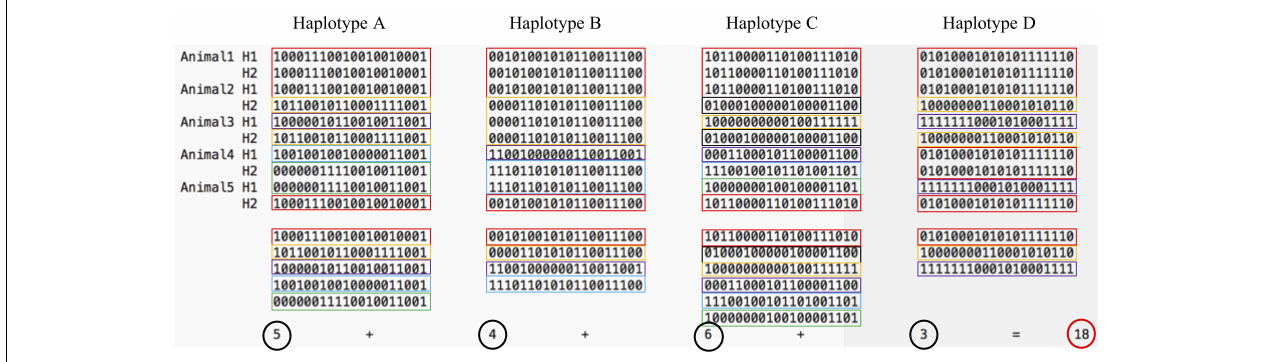
FIGURE 2 | The Genetic Diversity Index is the sum of the unique haplotypes found in a group of animals. On this figure, five animals carry in total 18 unique haplotypes (5 variants of haplotypes A, 4 variants of haplotype B, 6 variants of haplotype C, and 3 variants of haplotype D). Colors highlight the unique haplotype alleles of each haplotype